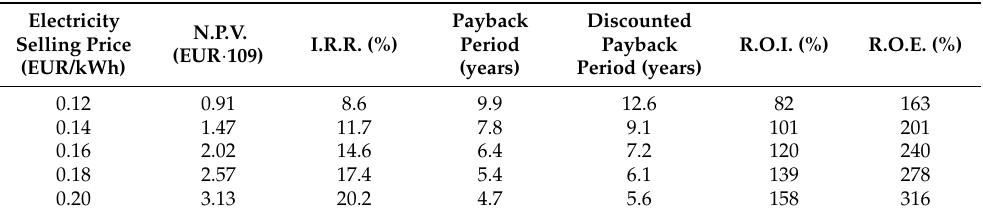
Table 14. Economic indices of the overall wind parks—PHS plant investment versus the electricity selling